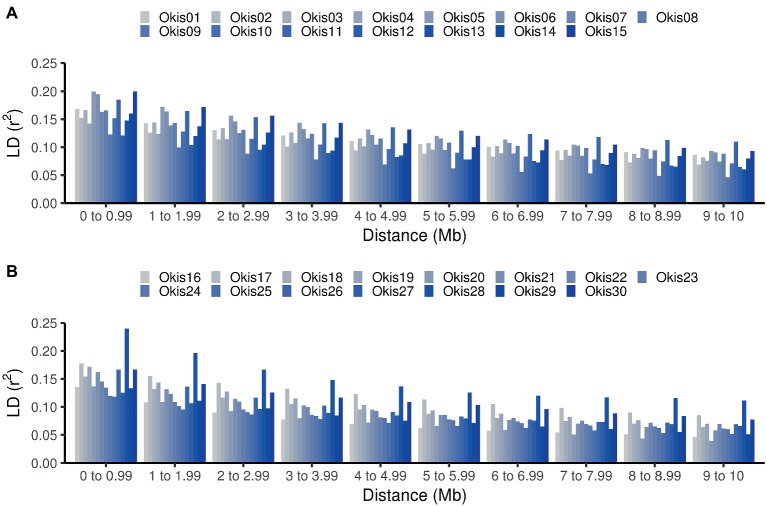
Linkage disequilibrium estimations along the 30 chromosomes of coho salmon. Average values of LD measured as r2 per chromosome, according to distances between SNPs. Estimated values are shown from Okis01 to Okis015 (A) and from Okis16 to Okis30 (B).